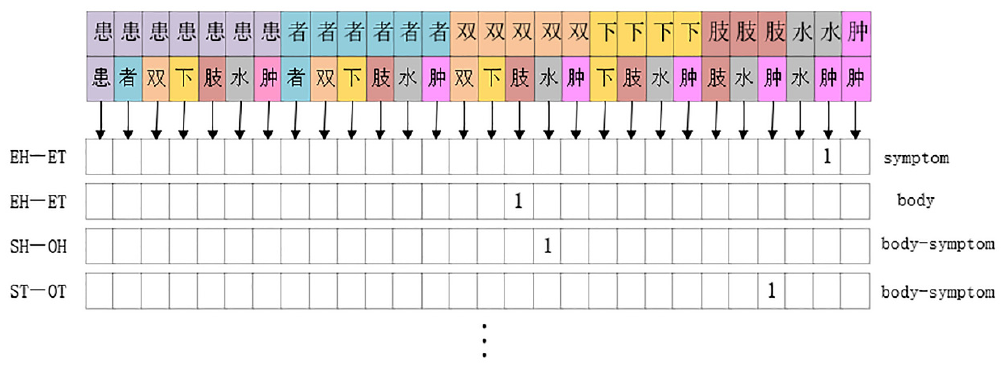
Figure 6. The handshake marked. For illustrative of word combinations, we use a different color for each word in the input sentence.